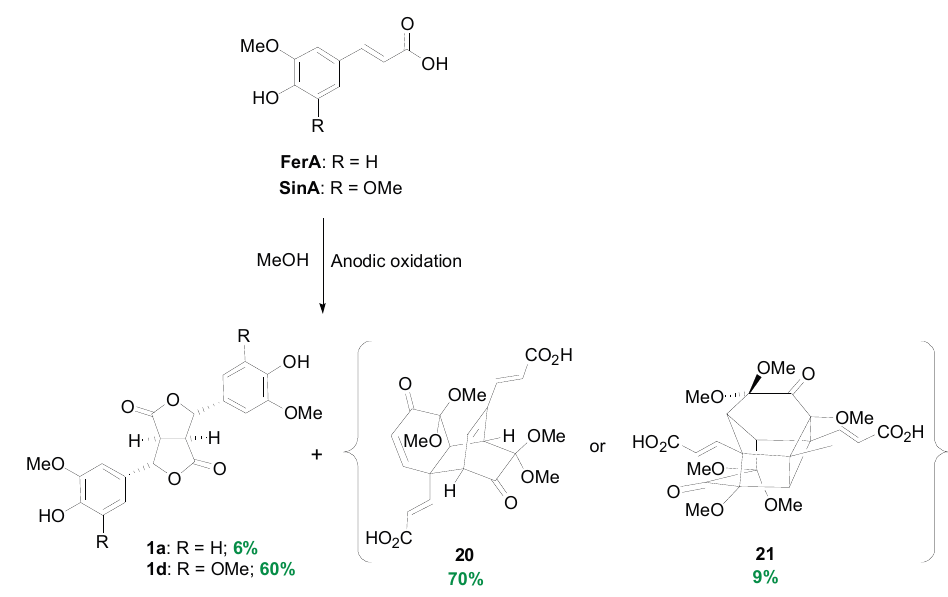
Scheme 15. Electrochemical dehydrodimerization of